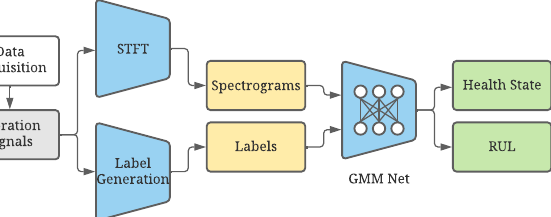
Figure 2. Framework of our proposed method for fault diagnosis and remaining useful life